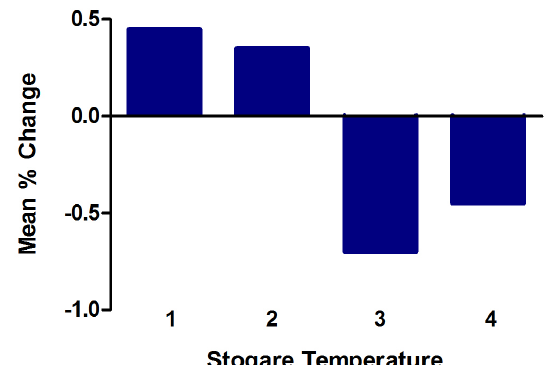
FIGURE 2 - Mean % changes in the conductivity of Hippophae rhamnoides emulsion from zero time to 60 days. 1= 8 °C, 2= 25 °C, 3= 40 °C, 4= 40 °C + 75% RH.